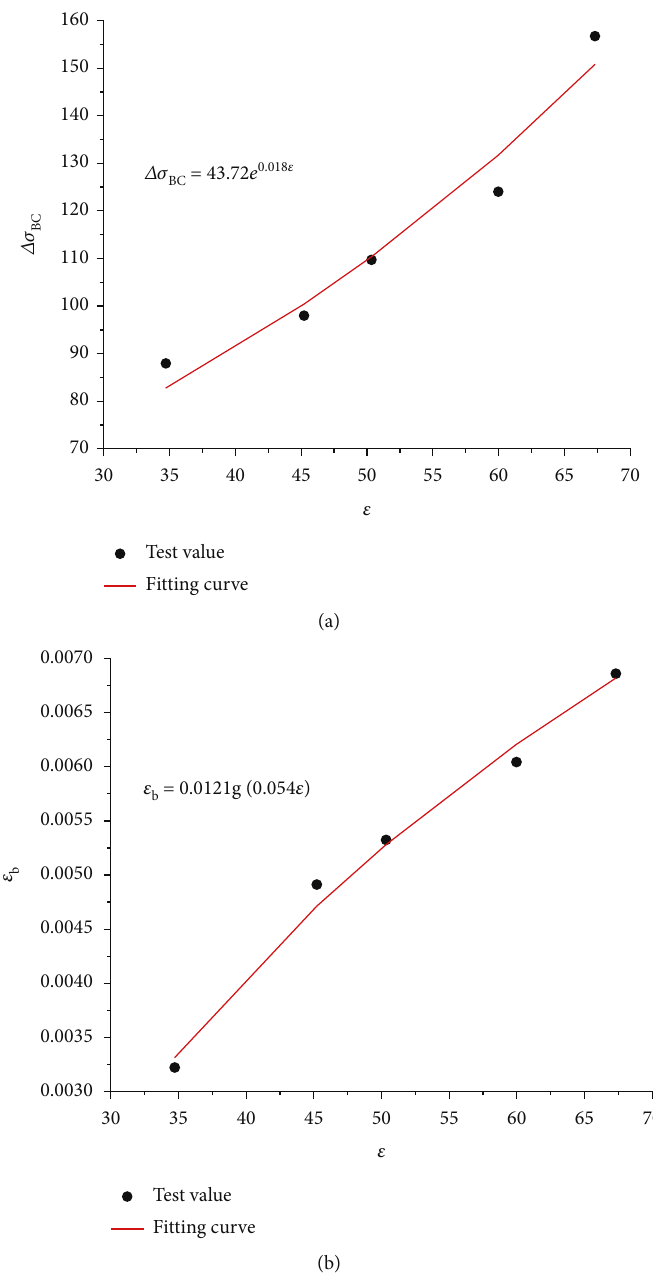
ε BC , b , and strain rate. (a)